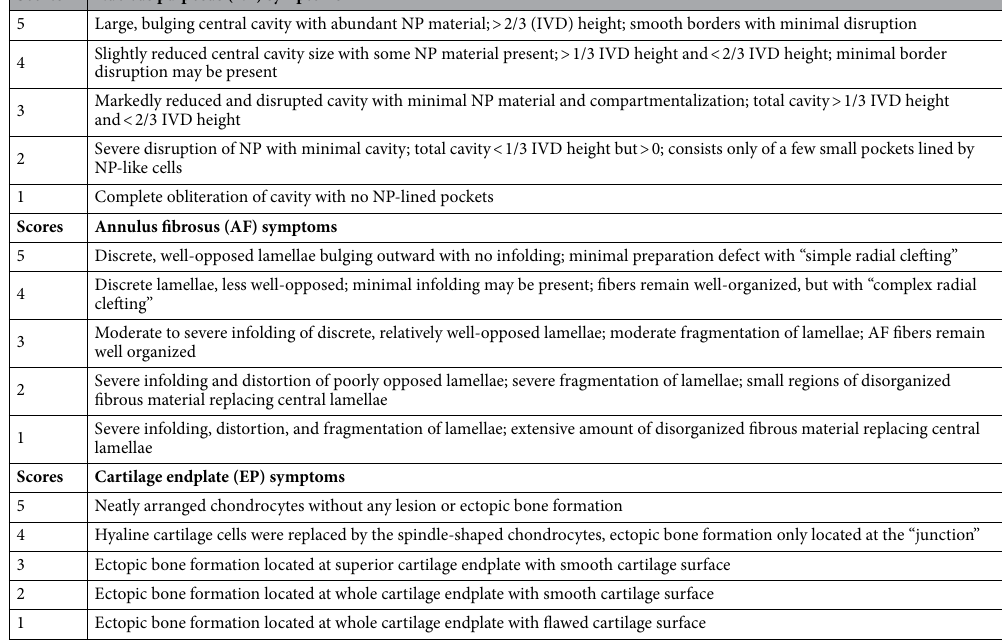
Table 1. Histological grading scale criteria based on Norcross et al. 28 . This scale mainly scores the disruption of nucleus pulposus central cavity, cellularity and collagen fiber orientation of annulus fibrosus and the degree of ectopia ossification of cartilage endplate. Simple radial clefting = the presence of radial gaps between AF lamellae with minimal fragmentation; complex radial clefting = the presence of radial, transverse, and/ or oblique gaps in the lamellae with significant fragmentation; junction = the triangle junction between the cartilage endplate and the annulus fibrosus.